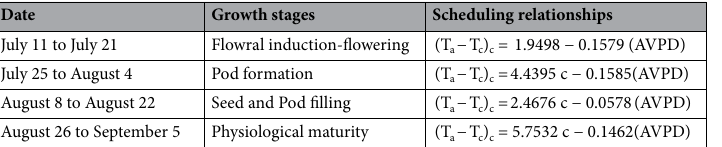
Table 9. Relationships used for black gram irrigation scheduling. (T c —T a ) c : the permitted difference between the canopy temperature and air temperature; AVPD: air vapor pressure deficit.